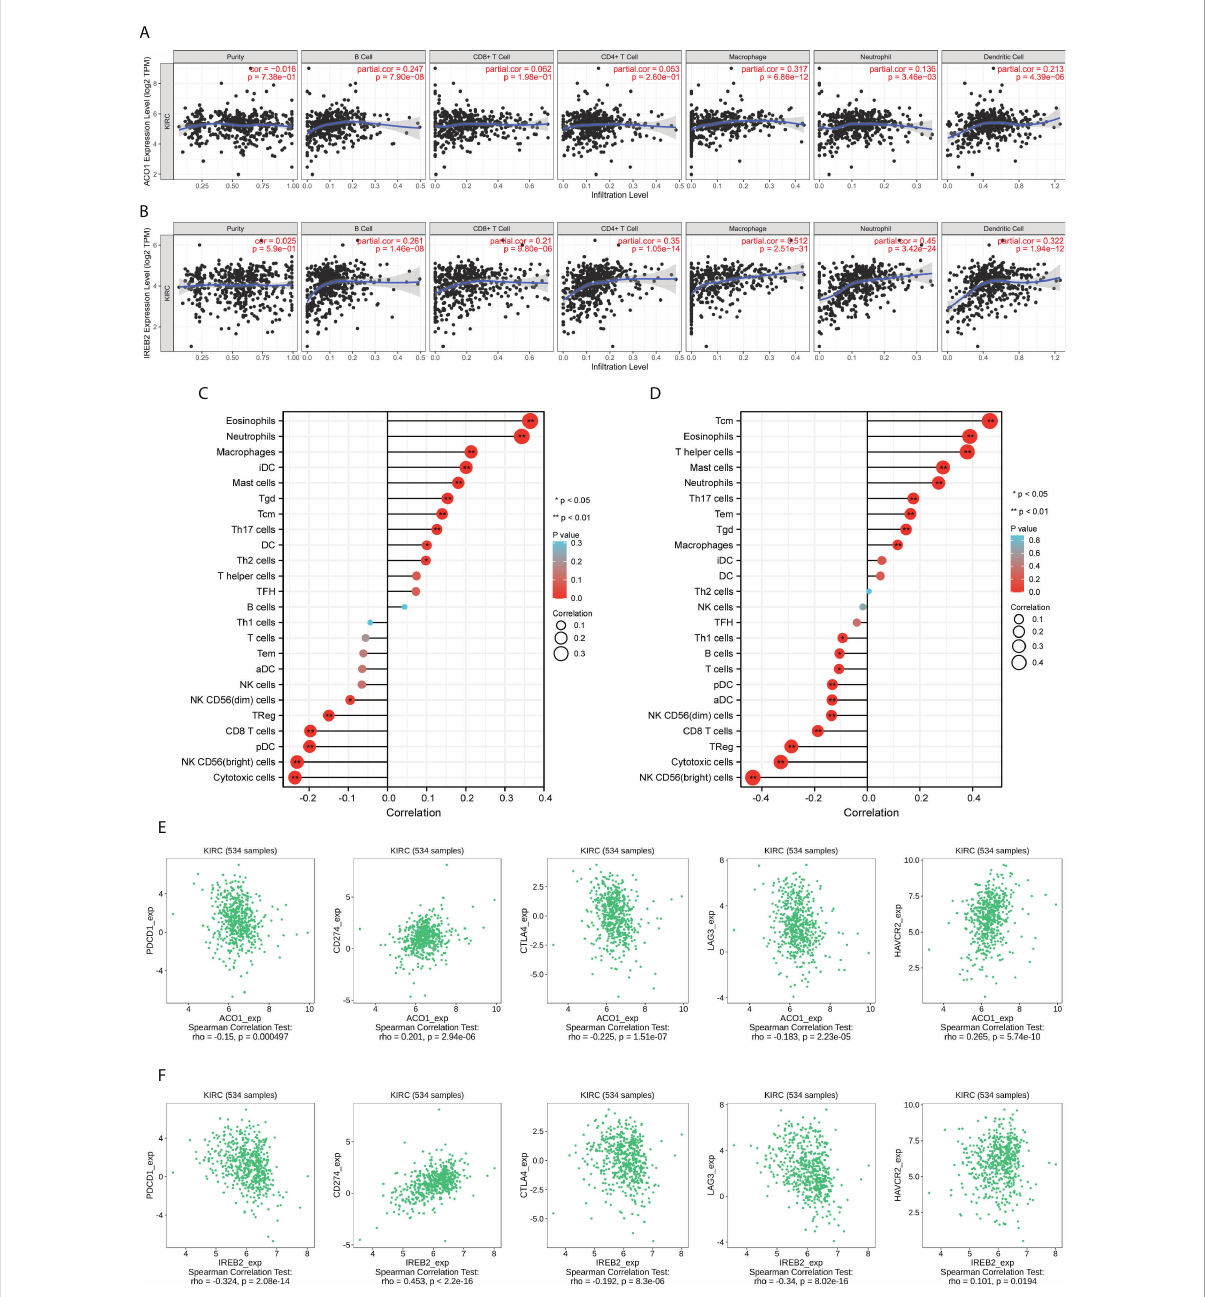
FIGURE 9 ACO1 and IREB2 expression positively correlates with immune in fi ltration. The correlation of ACO1 and IREB2 expression levels with the immune in fi ltration in KIRC tissues was analyzed using TCGA dataset. (A, B) Correlation analyses of ACO1 (A) and IREB2 (B) with the in fi ltration of different immune cells using the TIMER2.0 database. (C, D) A lollipop chart showed the correlations of ACO1 (A) , IREB2 (B) for all 24 immune cell types. iDC, immature DC; Tem, effector memory T cells; TFH, follicular helper T cells; Tgd, gamma delta T cells; pDC, plasmacytoid DC; aDC, activated DC; Tcm, central memory T cells using the XIANTAO platform. (E, F) Scatter plots of the correlations between ACO1 (E) and IREB2 (F) expression and PD-1, PD-L1, CTLA-4, LAG3, and HAVCR2 in KIRC using the TISIDB